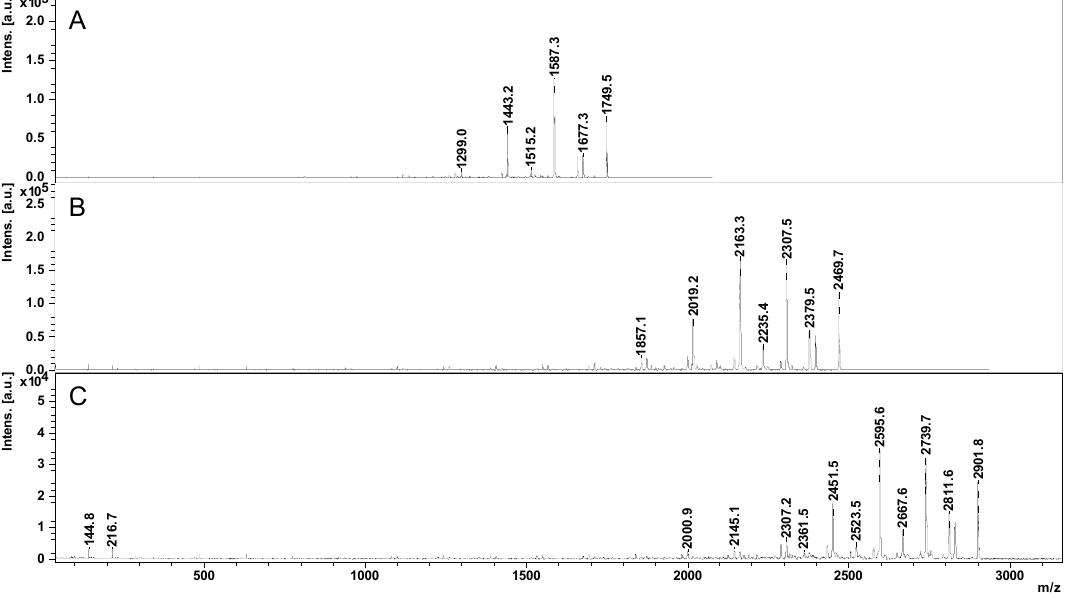
Figure 5. Comparative view of the MS/MS spectra of the CD-LA, K-charged parent ions: [CD-LA 4 + K] + ( A ), [CD-LA 9 + K] + ( B ), and [CD-LA 12 + K] + ( C ).